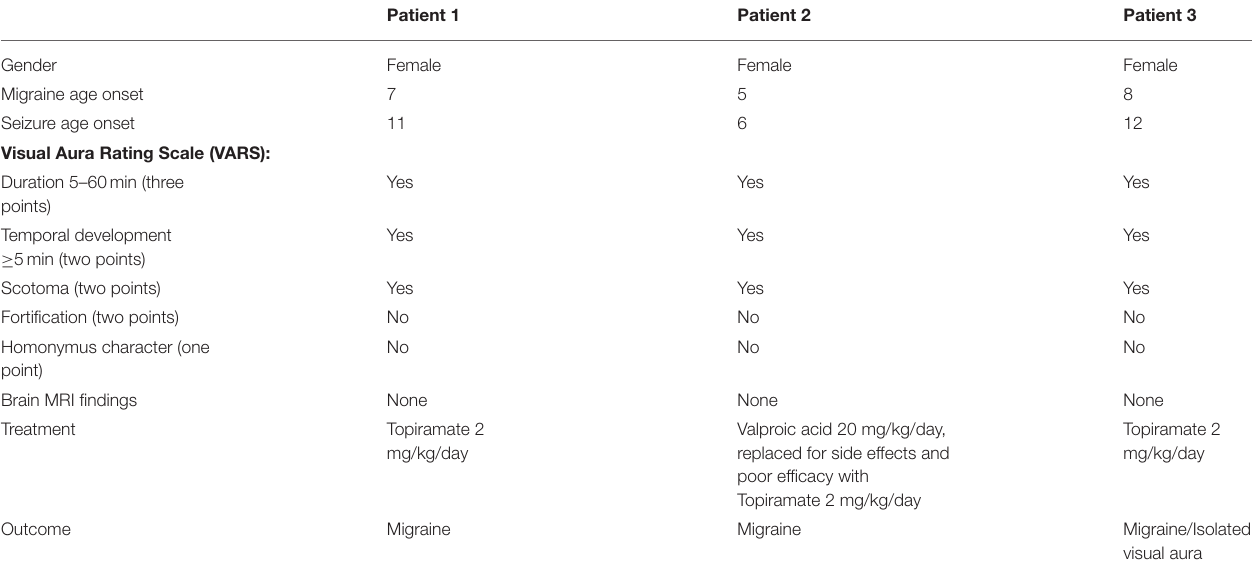
TABLE 1 | Main features of clinical cases and Visual Aura Rating Scale